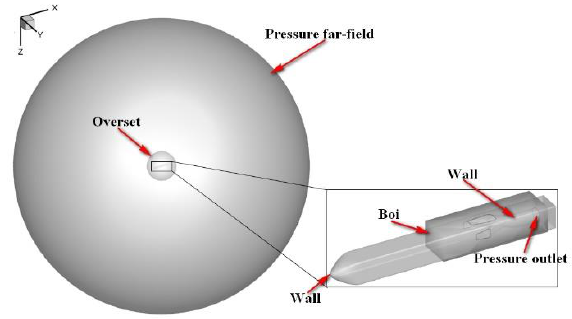
Figure 6. Setting of Transient Boundary Conditions.